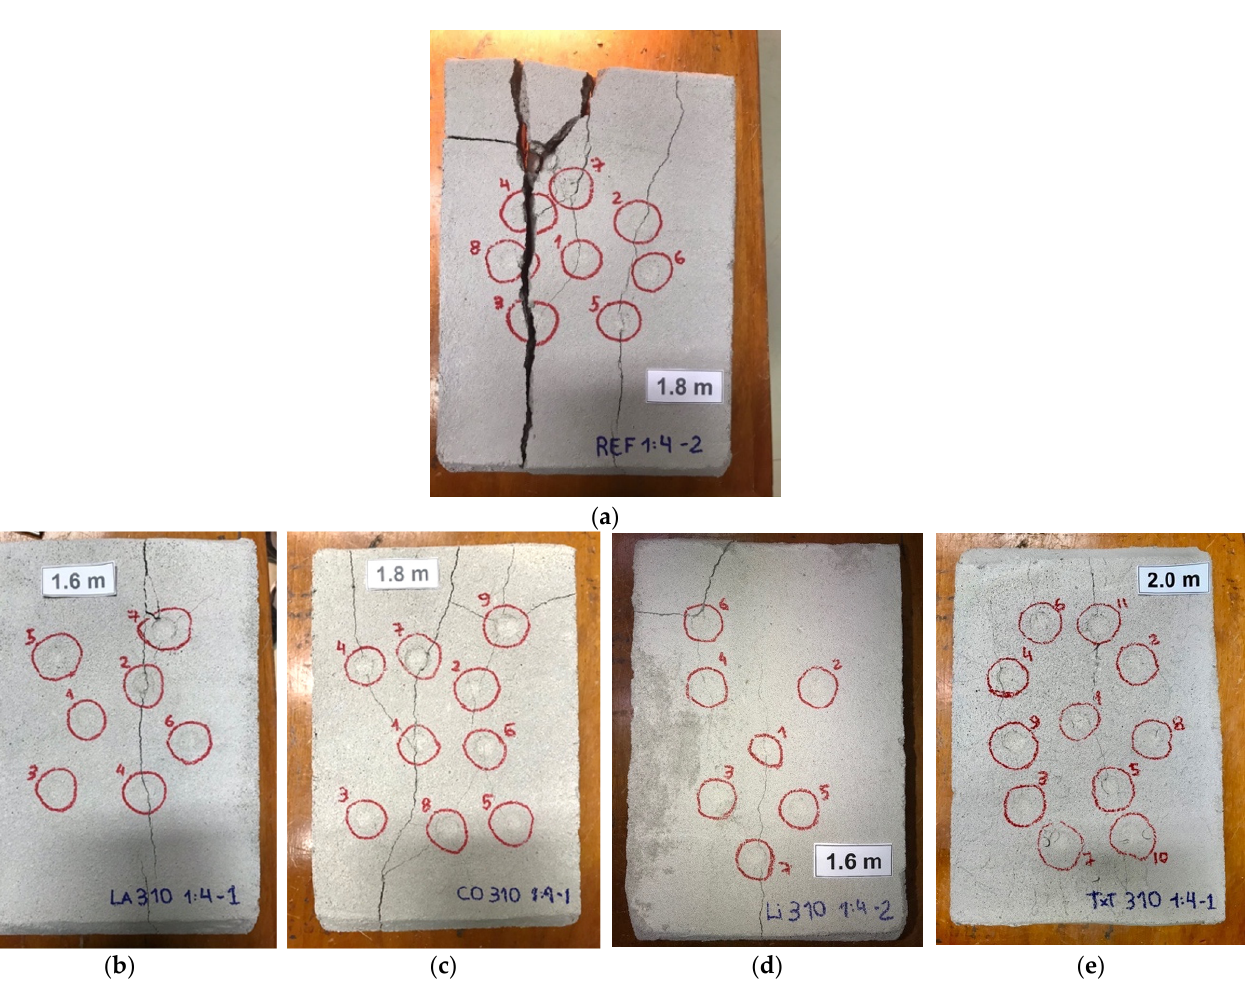
Figure 8. Crack pattern of cement mortars, before ageing, at failure: ( a ) reference mortar, ( b ) wool fibre-reinforced mortar, ( c ) coir fibre-reinforced mortar, ( d ) flax fibre-reinforced mortar and ( e ) textile-acrylic fibre-reinforced mortar.